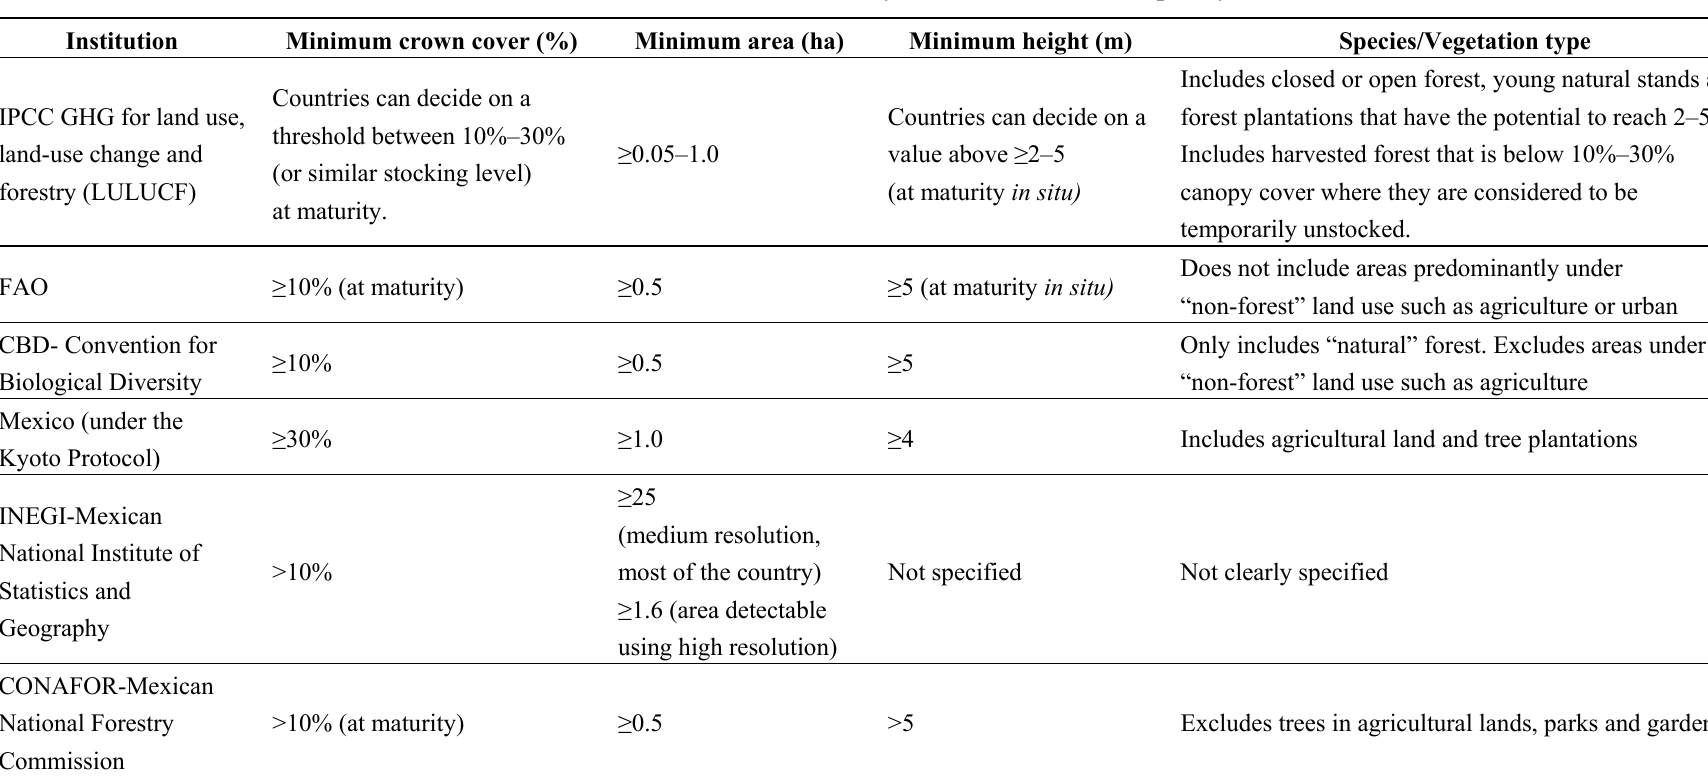
Table 1. Forest attributes used to define what is classified as “Forest” by relevant international policy bodies and Mexican national